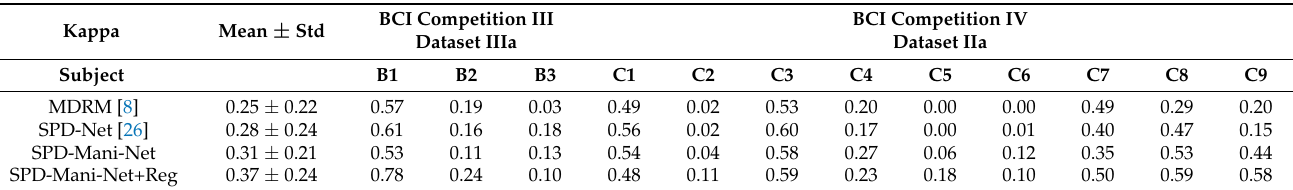
Table 6. Kappa coefficient for the EEG datasets from motor image multi-subject